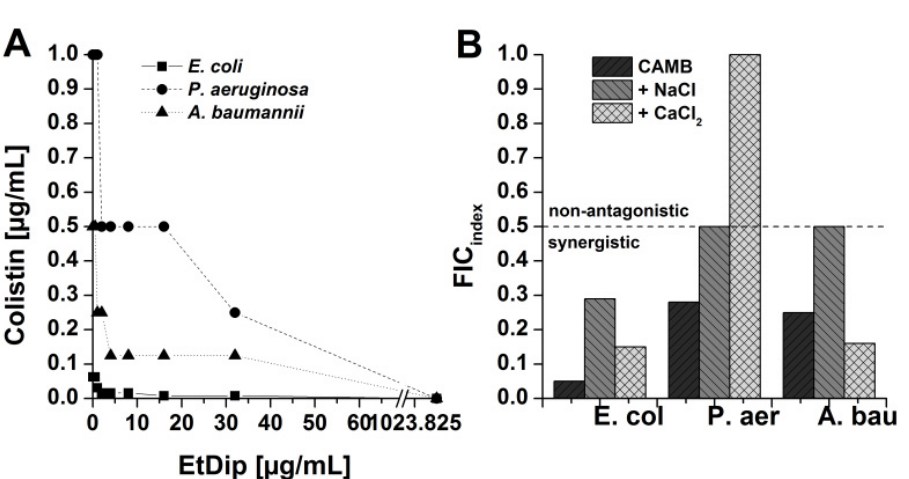
Figure 2. Interaction between EtDip and colistin. ( A ) Checkerboard assay against E. coli ATCC 25922, P. aeruginosa ATCC 27853 and A. baumannii ATCC 19606 in cation-adjusted Mueller-Hinton broth ( CAMB ) depicted as an isobologram. ( B ) Calculated FIC index (fractional inhibitory concentration index) values against E. coli , P. aeruginosa ( P. aer. ), and A. baumannii ( A. bau. ) in CAMB, CAMB adjusted to 150 mM NaCl ( + NaCl ), and CAMB adjusted to 1.25 mM CaCl 2 ( + CaCl 2 ). FIC index values ≤ 0.5 indicate synergy.